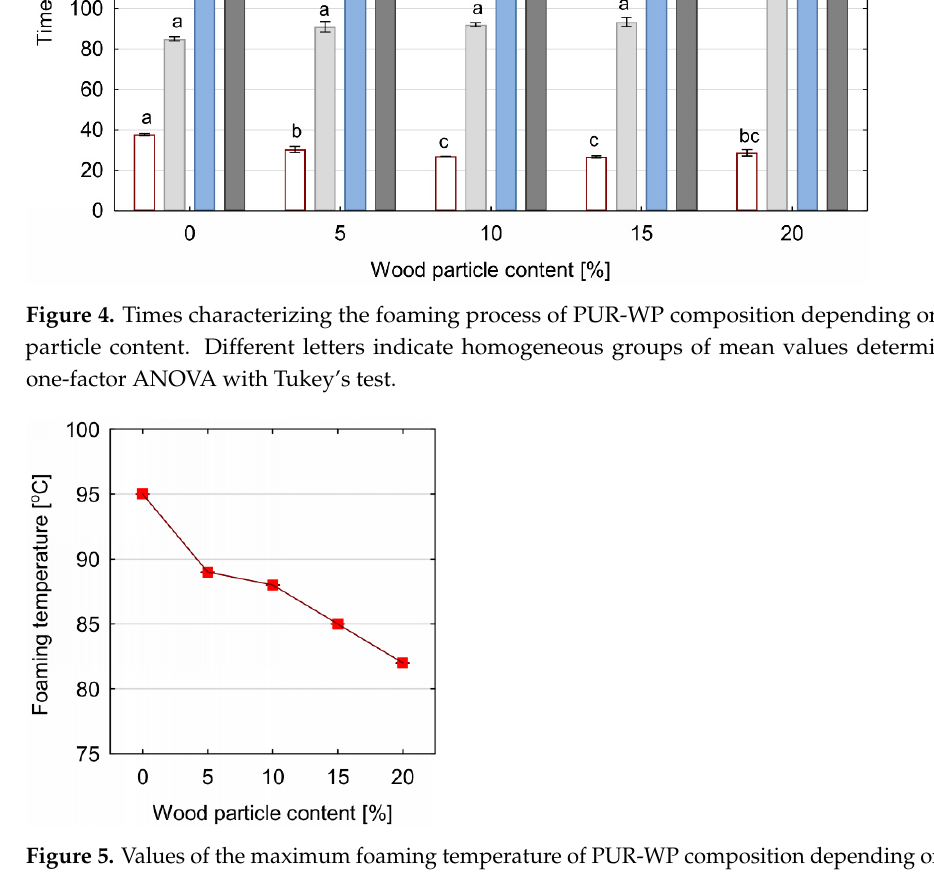
Figure 5. Values of the maximum foaming temperature of PUR-WP composition depending on wood particle content.